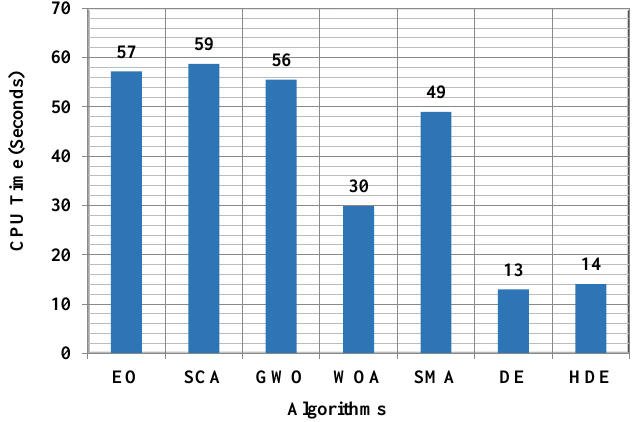
Figure 12. Comparison of algorithms in terms of CPU time.